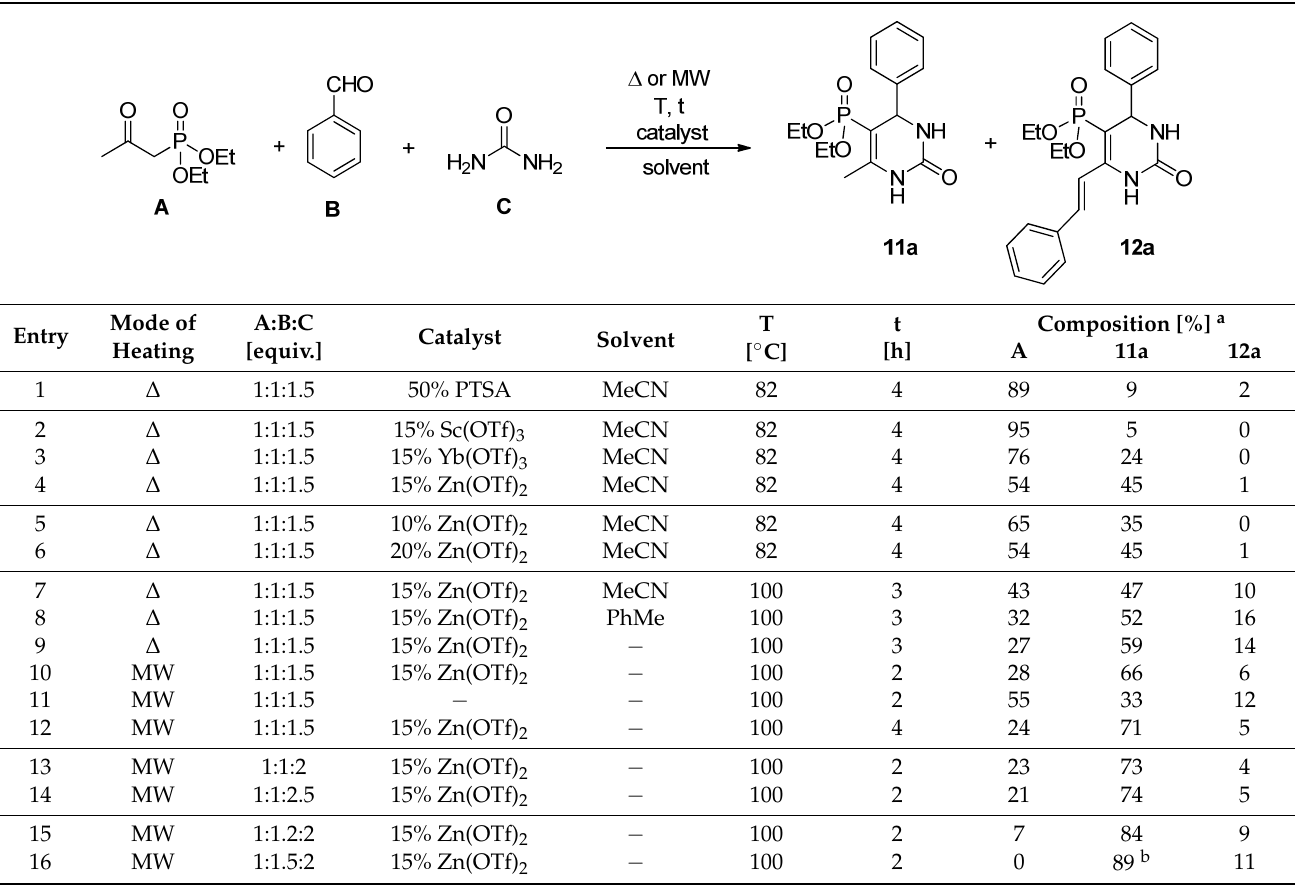
Table 1. Biginelli reaction of diethyl (2 ‐ oxopropyl)phosphonate, benzaldehyde and urea.